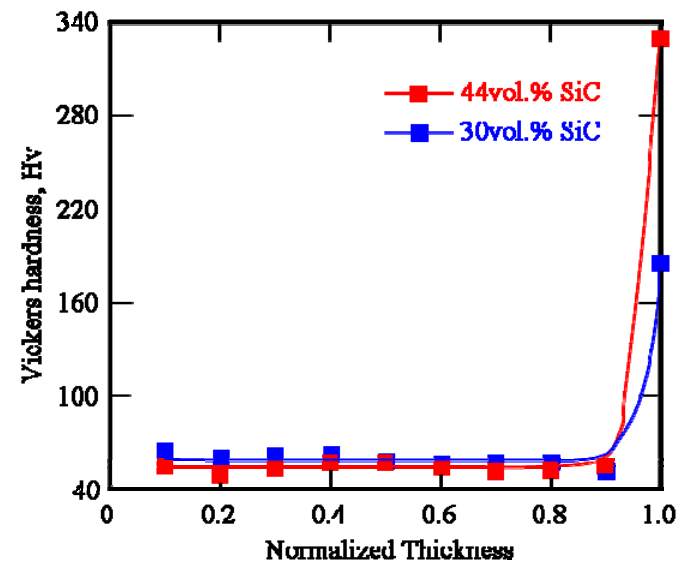
Figure 12. Vickers hardness of Specimens 2 and 4 as a function of normalized